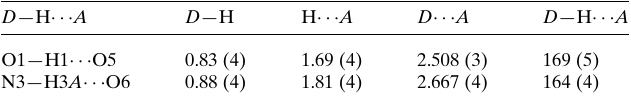
Table 1 Hydrogen-bond geometry (A˚ , (cid:4) ).